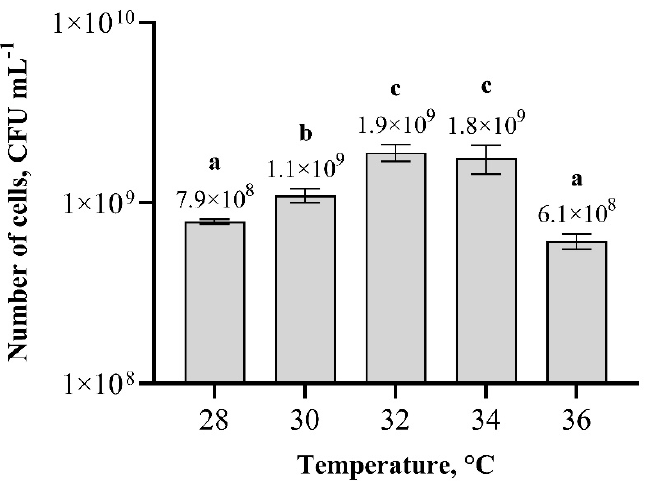
Figure 7. Effect of temperature on the biomass production of Paenibacillus sp. MVY-024. The values marked with the same letter have no significant difference at p ≤ 0.05.